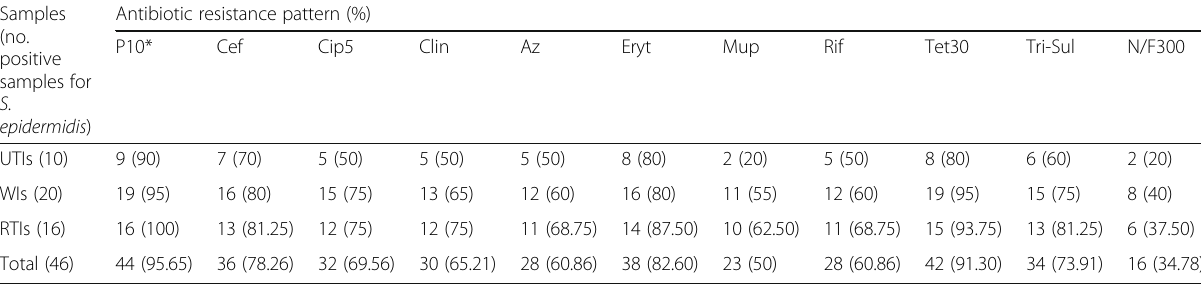
Table 1 Antibiotic resistance pattern of the S. epidermidis strains isolated from different types of hospital infectious samples Samples (no. positive samples for S. epidermidis